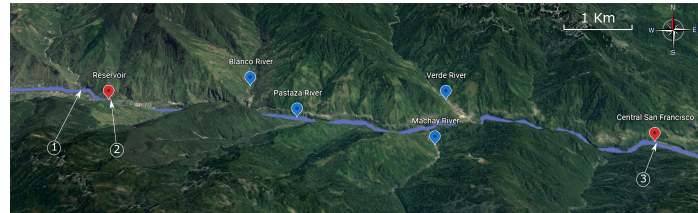
Figure 1. San Francisco hydroelectric power plant